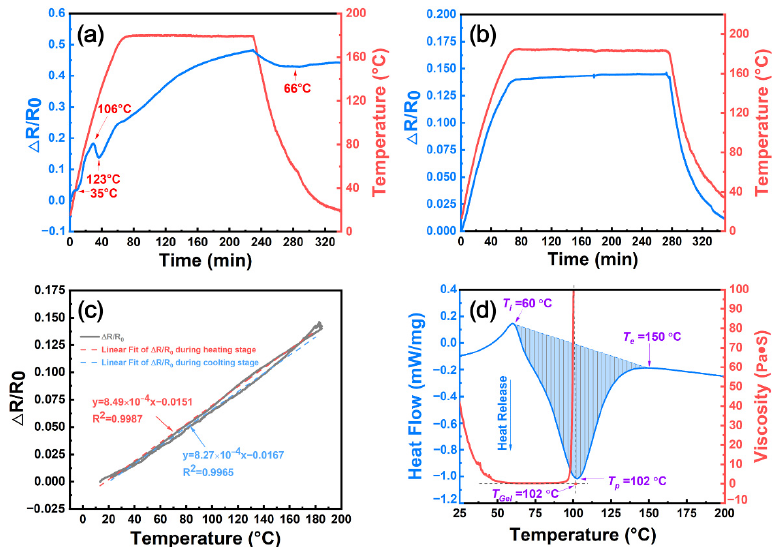
Figure 2. ( a ) The variation in electrical resistance and temperature with time during curing process for CNT/E51-DAD-90 sample, the electrical resistance variation with ( b ) time and ( c ) temperature for pristine CNT film, and ( d ) the viscosity and heat flow with temperature for E51-DAD resin system.